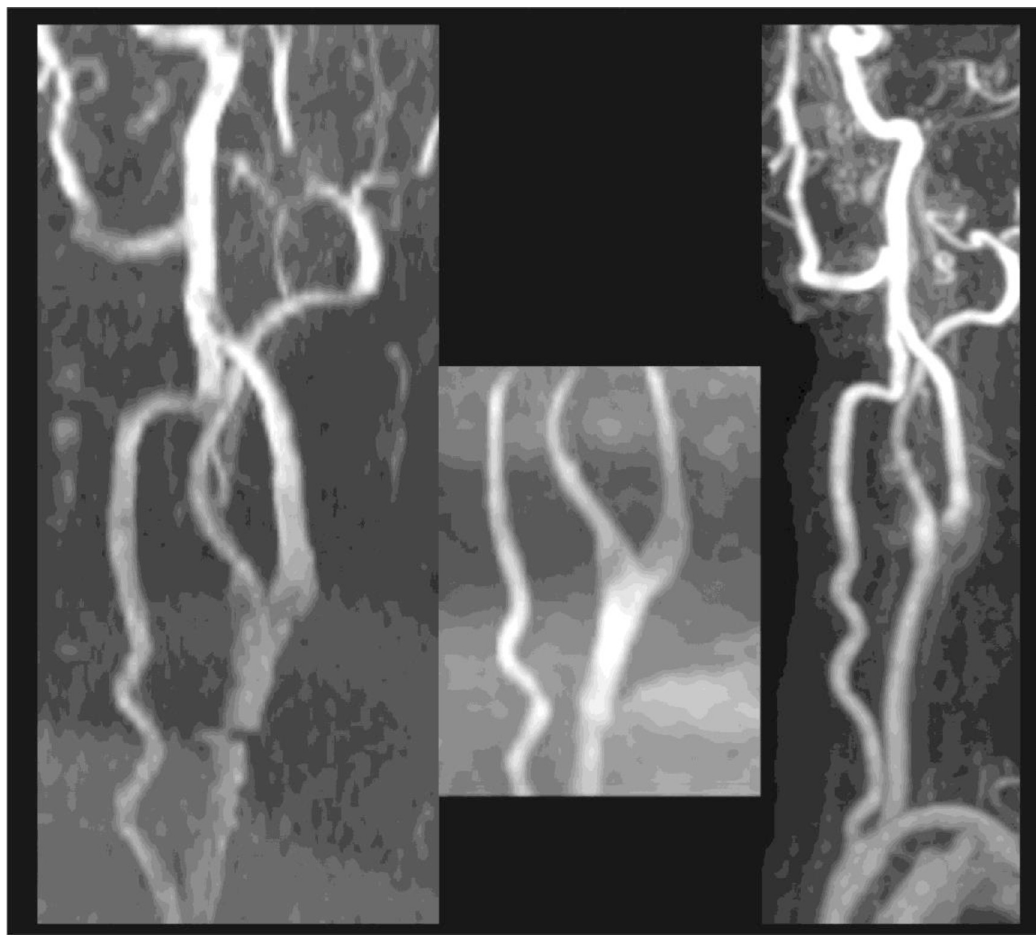
Fig 3. MRA images chosen to show variability of CE-MRA interpretations overcalling stenosis relative to TOF studies. Variability of interpretation of 2D (left), 3D (middle) and CE-MRA (right) for patient 113. Scores for the 6 readers were: 2D- 1,2,1,1,1,1 (average 1.2); 3D-1,1,1,1,1,1 (1.0); CE- 1,3,1,5,5,4 (3.2) where 1 = 0–30% stenosis, 2 = 31–50%, 3 = 51–70, 4 = > 70%, 5 = near occlusion, 6 = occluded. Average quality rating were 2DTOF = 2.5, 3DTOF = 1.5, CEMRA = 3.1.